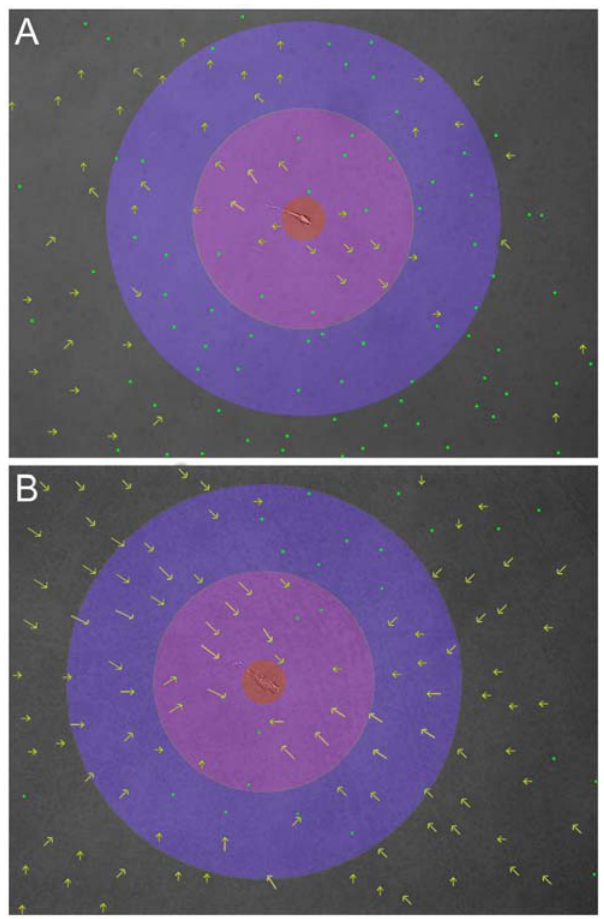
Figure 4. Cells apply asymmetric strain fields. Example displace- ment patterns of fibroblasts on 2 mg/ml fibrin gels treated with either blebbistatin (A) or nocodazole (B). To allow for visualization in this format only 1/10 th of all tracked beads are shown and displacements have been magnified 5 6 and indicated by the arrows which point in direction of bead movement after drug treatment. The red circle has a radius of 50 m m. The radius of the purple circle is 250 m m and the radius of the blue circle is 450 m m.